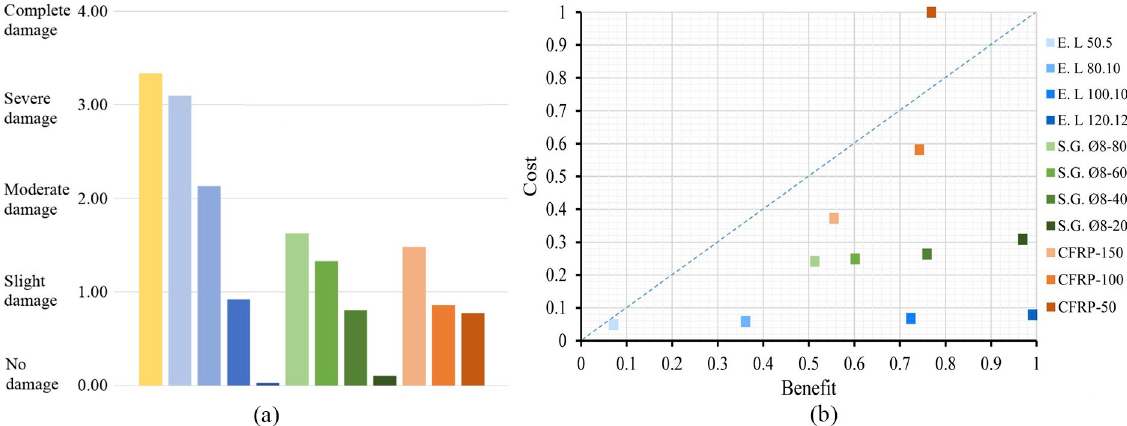
Fig 11. DI for each retrofitting solution (a) and cost-benefit index